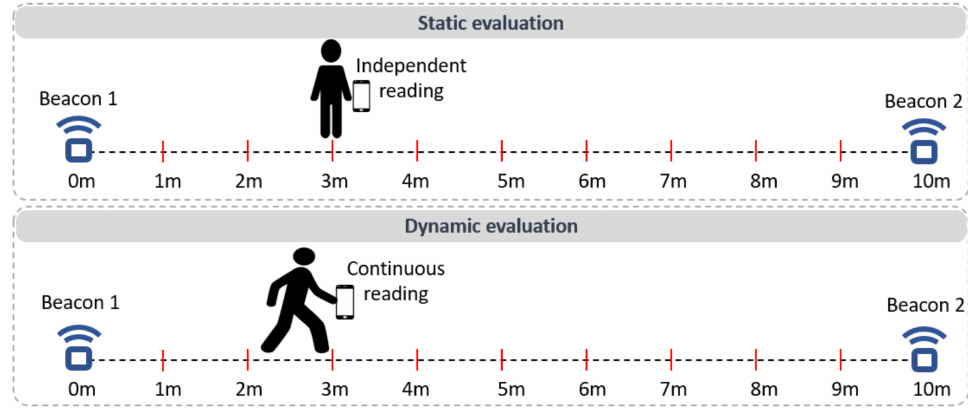
Figure 7. Evaluation of the beacon-based localization: static scenario ( top ) and dynamic scenario ( bottom